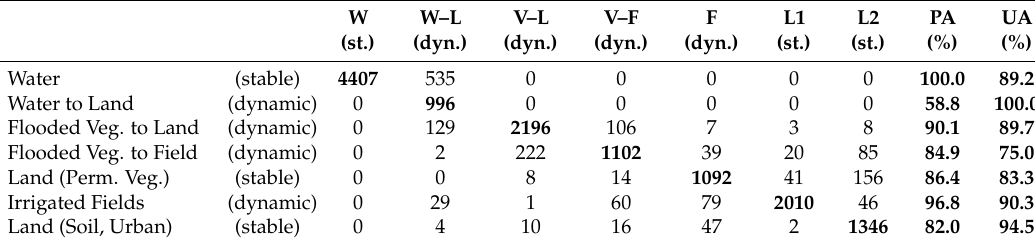
Table 7. Accuracy assessment of the multitemporal classification with the classes open water (W); water to land/soil (W–L); flooded vegetation to land/soil (V–L); flooded vegetation to irrigated fields (V–F); and irrigated fields to land/soil or land/soil to irrigated fields (F–L/L–F); land with permanent vegetation (L1); land soil, rock, urban (L2). The error matrix including Producer’s Accuracy (PA) and User’s Accuracy (UA) are stated for each class. W